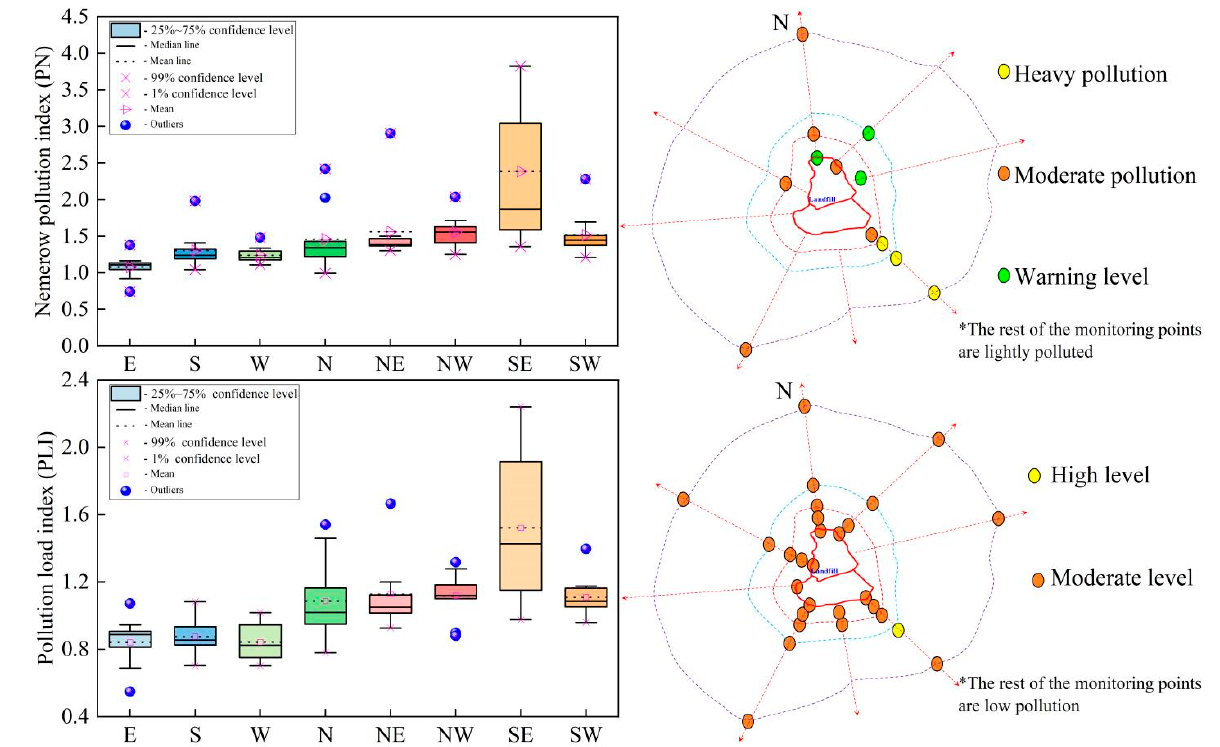
Figure 5. Levels of heavy metal contamination in landfill soil.